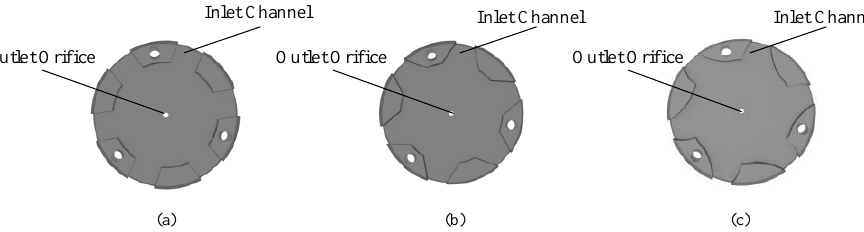
Figure 3. The roof with different inlet channel: ( a ) direct channel; ( b ) diffuser/nozzle channel; ( c ) petal-shaped channel.